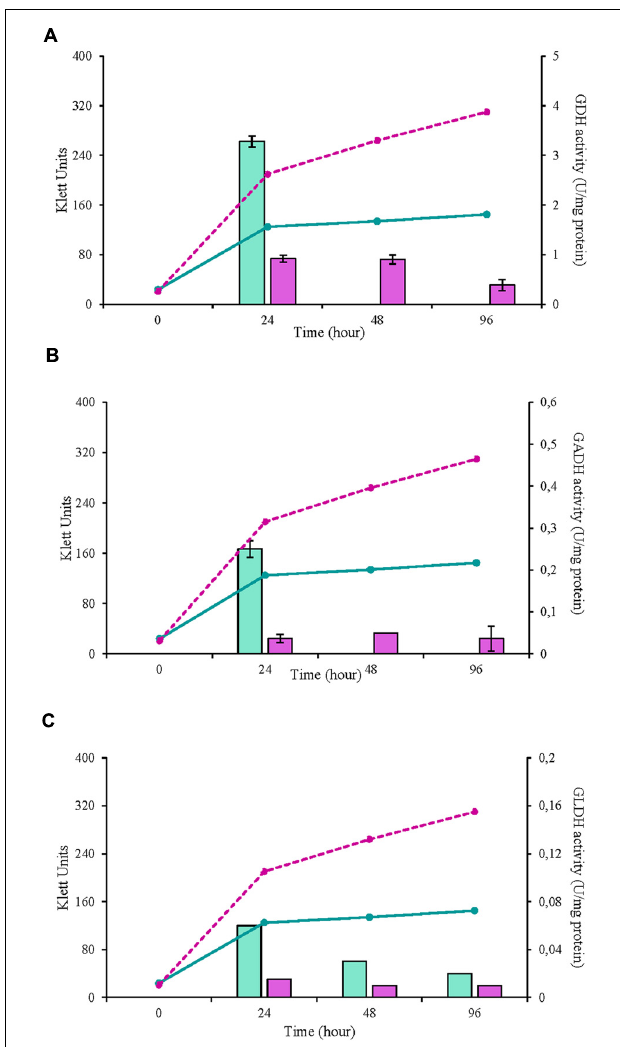
FIGURE 3 | Enzyme activity and growth (expressed in Klett units) of two Acetobacter malorum strains at three different growth stages (24, 48, and 96 h). (A) Glucose dehydrogenase activity (mGDH); (B) Gluconate dehydrogenase activity (GADH); (C) Glycerol dehydrogenase activity (GLDH). Enzyme activity represented in bars: NBRC 108912 ( (cid:4) ), CECT 7742 ( (cid:4) ) and cell growth with lines: NBRC 108912 ( ); CECT 7742 ( ).